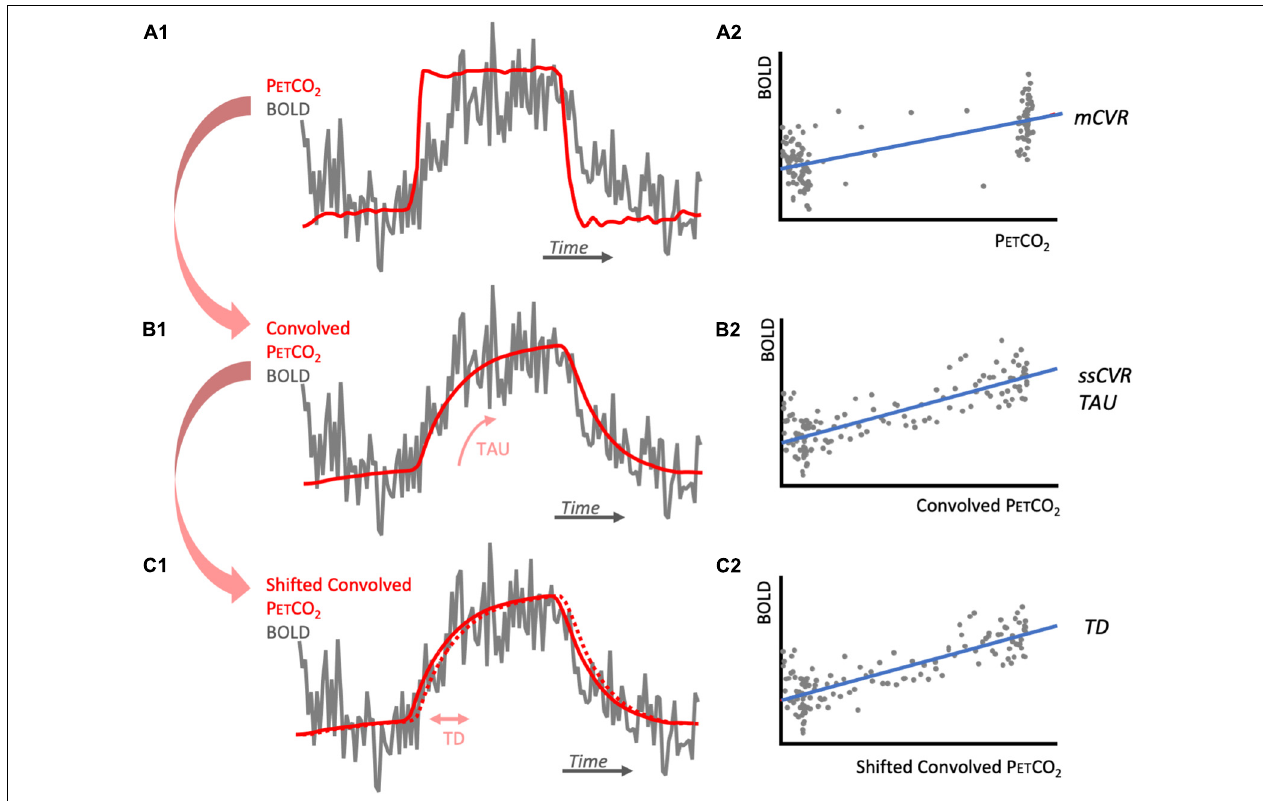
FIGURE 1 | Diagrams illustrating CVR metrics calculations. (A1) represents one voxel BOLD response (gray) to the step PETCO 2 (red). BOLD signal is regressed against PETCO 2 to obtain its slope, mCVR (A2) . The PETCO 2 is then convolved with an exponential function of time characteristic TAU that is chosen to maximize the correlation with the BOLD response (B1) . BOLD signal is then regressed against the convolved PETCO 2 to obtained its slope, ssCVR (B2) . The convolved PETCO 2 is then shifted to obtain maximum correlation with the convolved PETCO 2 . This shift corresponds to TD (C1) and the adjusted regression is represented in (C2) . Notes that for each of the regressions (A2,B2,C2) , BOLD signal drift is added to this model as a linear trend. For simplification, it is not represented